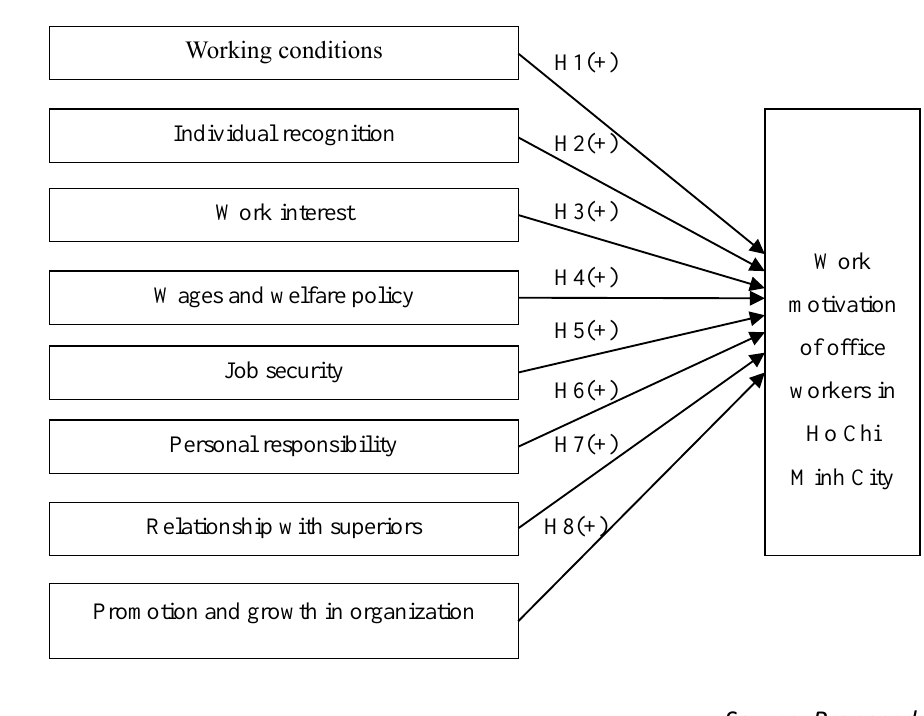
Figure 1: The proposed